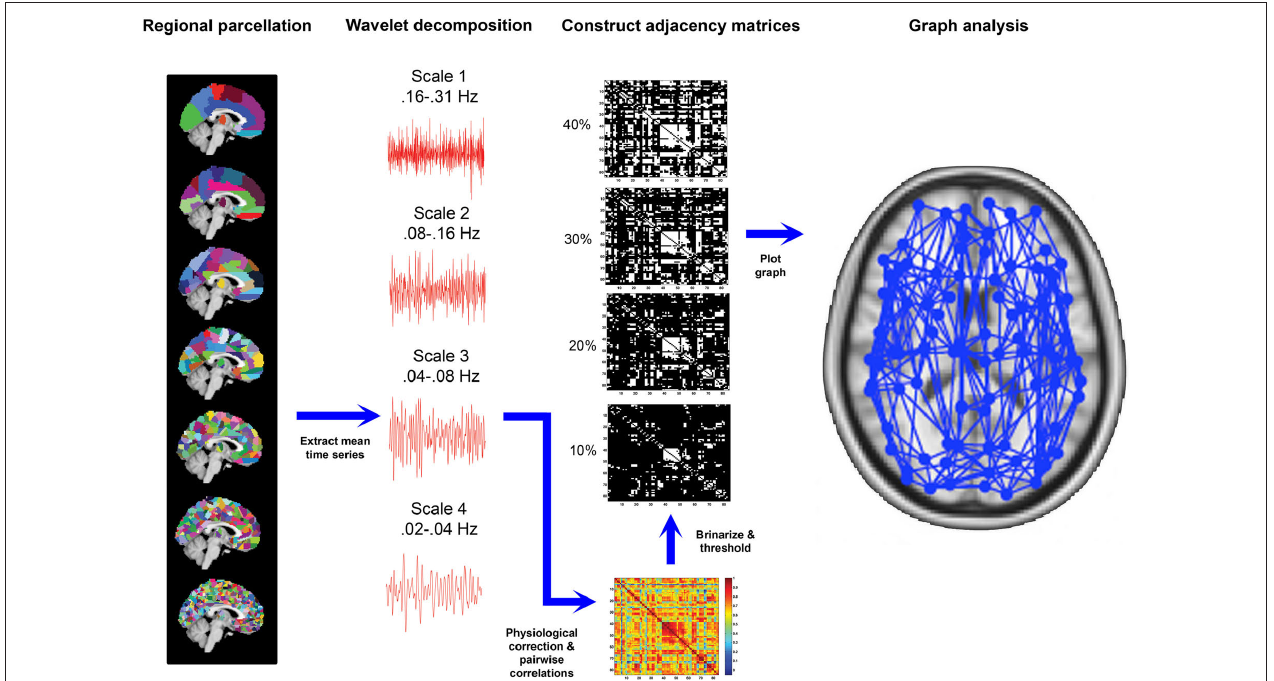
temporal correlations between each possible pair of regional corrected time series were calculated to generate a functional connectivity matrix for each template for each participant. These matrices were then thresholded and binarized across a range of connection costs (examples shown are for 10, 20, 30, and 40% costs). Far right: The thresholded, binarized adajacency matrices were used to generate graph-based representations of network connectivity, such that each region was represented as a node and each supra-threshold correlation as a connecting edge. These graphs were used as a basis for calculating graph